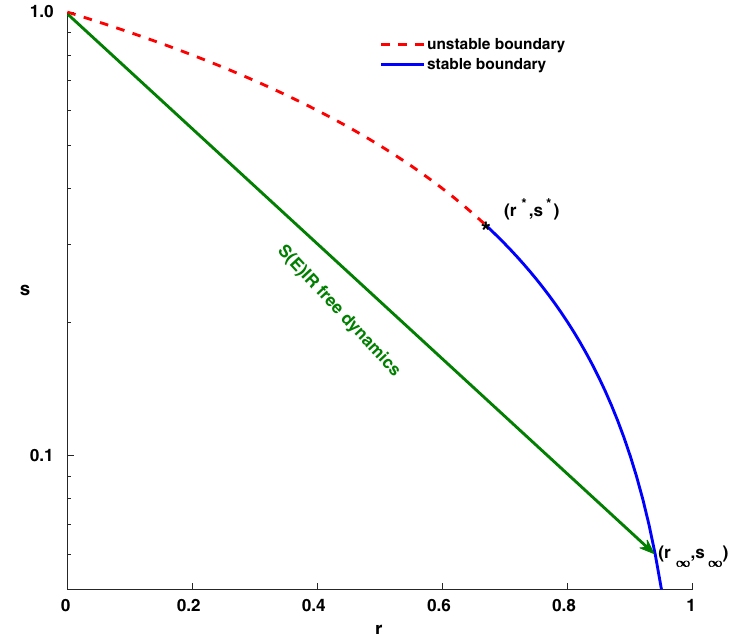
Figure 1. Unconstrained dynamics of S ( E ) IR epidemics. Horizontal axis: fraction r of recovered (immune) individuals; vertical axis: fraction s of susceptibles (logarithmic scale). The thick concave curve represents the “end of epidemic” boundary where no infectious individuals are present; the red dashed part of the curve represents unstable points, while the stable boundary is in blue. The thick green line (a straight line of slope − R 0 , see Eq. (3) represents an epidemic outburst from the initial state r = 0 , s = 1 where all individuals are susceptible; the arrow indicates the direction in which the epidemic evolves with time. The epidemic stops when reaching the “end of epidemic” boundary at the final size r ∞ ; in general, r ∞ > r ∗ (see "Methods" section). In the figure, R 0 = 3 and the unconstrained epidemic reaches r ∞ = 94% , a value well beyond the herd immunity threshold r ∗ = 67% . Vaccination—if available—is a much better option than letting the epidemic